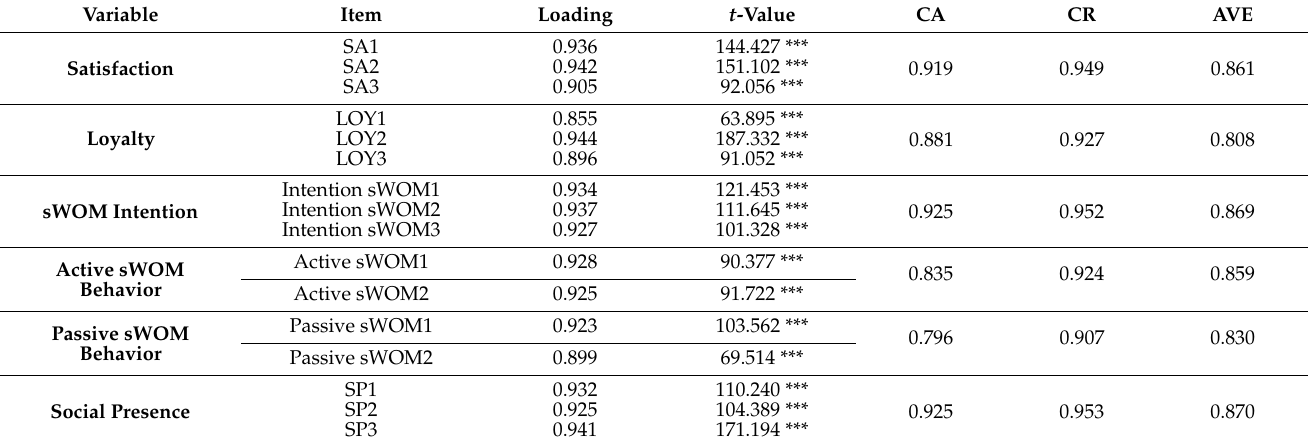
Table 3. Reliability and convergent validity of the measurement